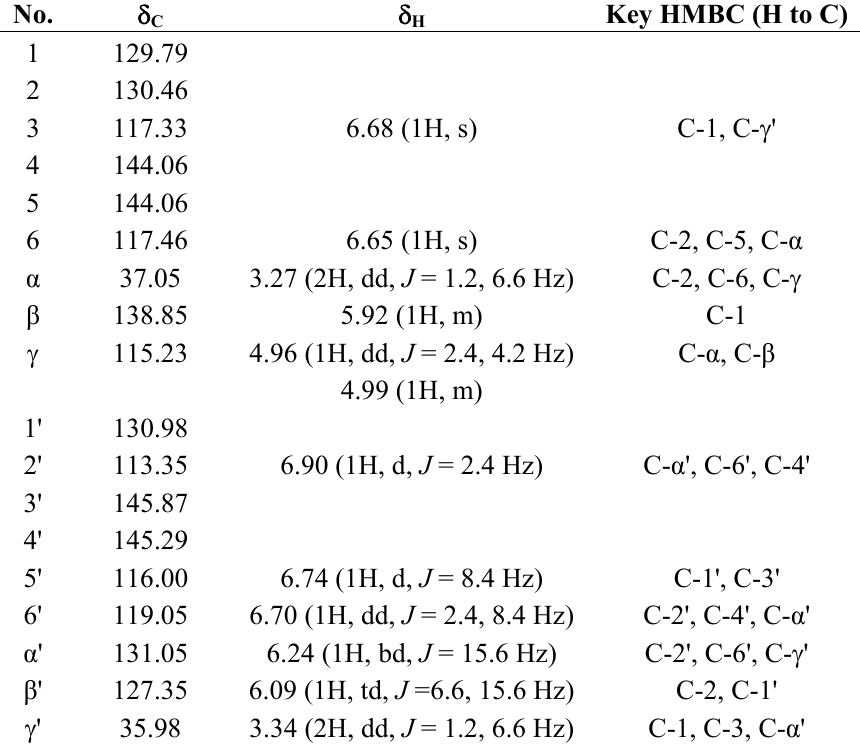
Table 1. 1 H-(600 MHz) and 13 C-NMR (150 MHz) data of compound 1 (in acetone- d ppm, J in